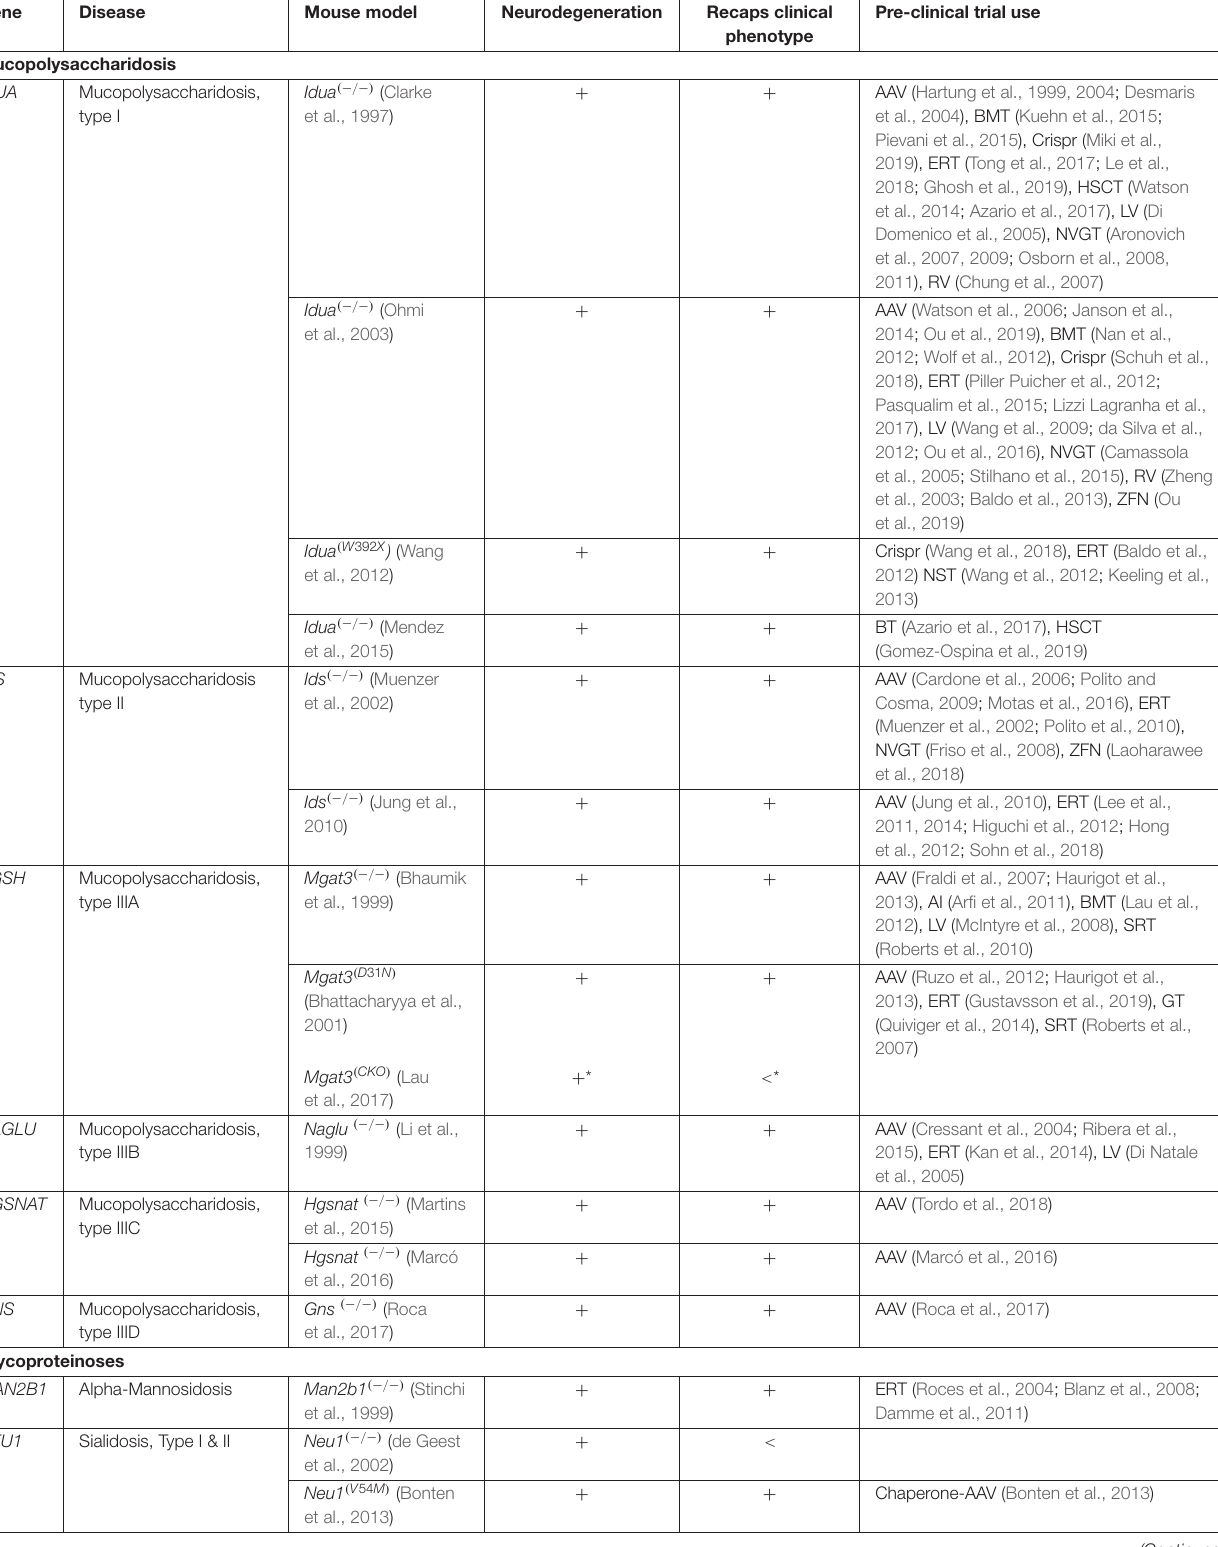
TABLE 1 | List of LSDs having neurodegeneration and currently available pre-clinical mouse